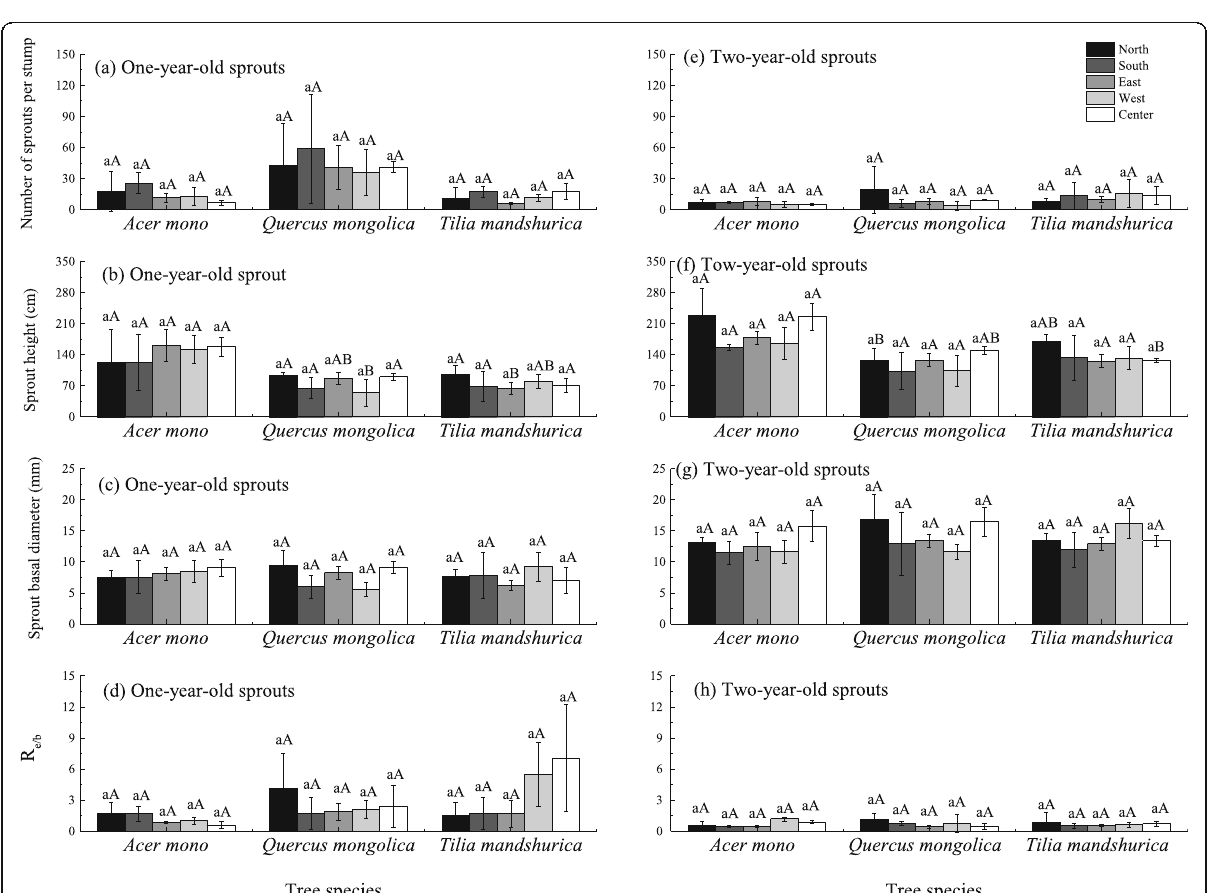
Fig. 3 Sprout density, growth (sprout height and basal diameter), and survival ( R e/b ) of 1-year-old and 2-year-old sprouts at different within-gap positions for three tree species. The data are presented as the mean ± S.D. Different capital letters indicate significant differences ( P < 0.05) among tree species. Different lowercase letters indicate significant differences ( P < 0.05) among within-gap